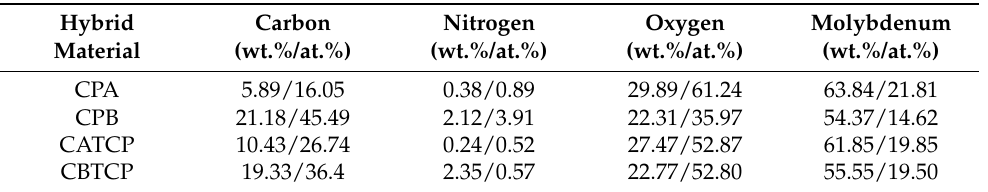
Table 3. EDS analysis of the hybrid materials (powder samples).